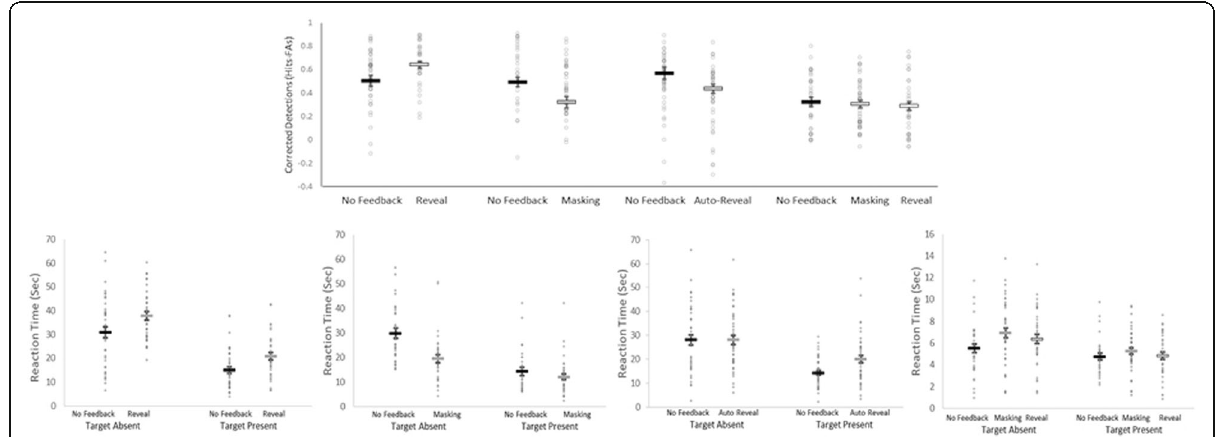
Fig. 2 The top panel presents the corrected accuracy (percent hits minus percent false alarms) for each experiment and condition. The small gray circles are individual subjects ’ data, the wide markers are the mean values, and error bars represent the SEM. Means for the control conditions are presented in black , and the means for the various feedback conditions are presented in gray . The bottom panel presents the mean reaction times for the correct target-absent responses for each experiment and condition. The small gray circles are individual subjects ’ data, the wide markers are the mean values, and error bars represent the SEM. Mean values for the control conditions are presented in black , and the mean values for the various feedback conditions are presented in gray. FAs False alarms